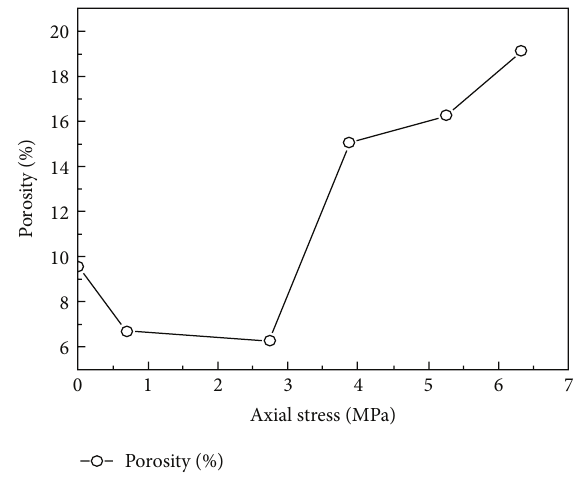
Figure 9: Relationship between RSA porosity and axial